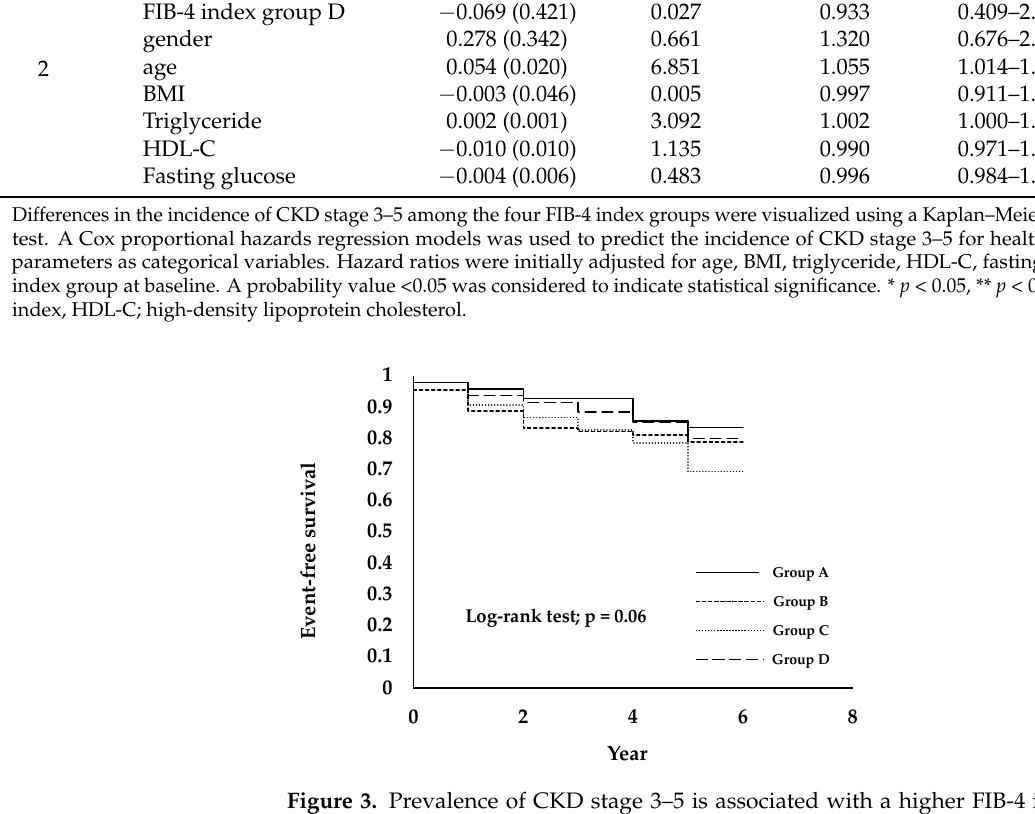
Table 4. Multivariable analysis of the hazard ratios for CKD stage 3–5 in Study 2.